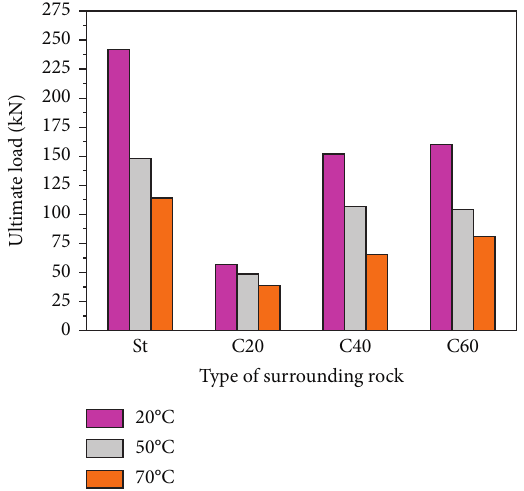
Figure 8: Ultimate pull-out strength of specimens.